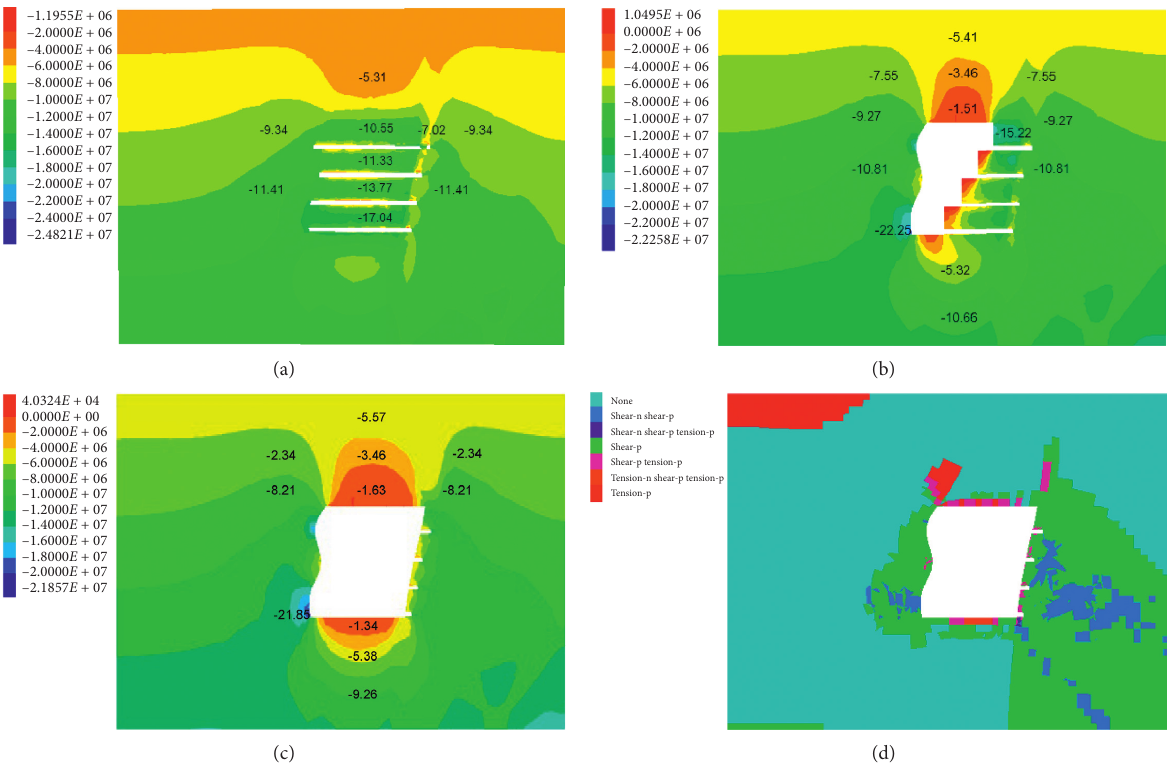
Figure 12: Vertical mining stress evolution cloud diagram: (a) early mining, (b) mining, (c) mining is complete, and (d) plastic zone.